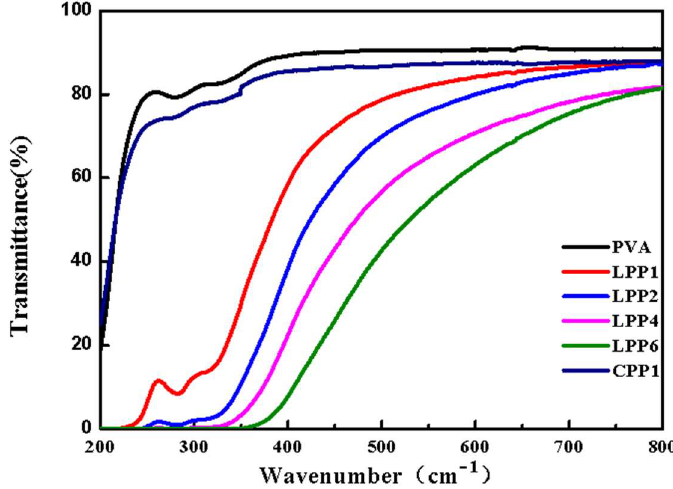
Figure 5. The UV-visible transmittance of the nanocomposite